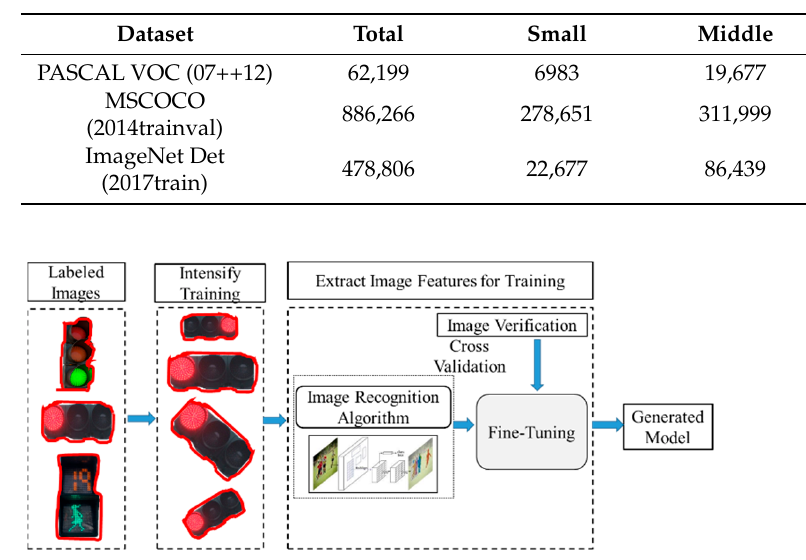
Table 2. Distribution of object size (BBox size) in open-source datasets.